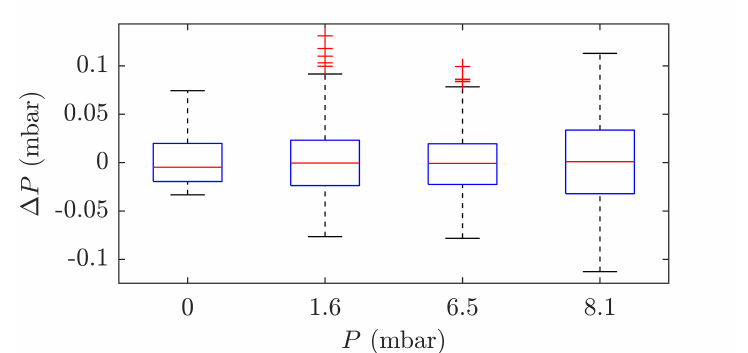
Figure 11. Static pressure measurement stability